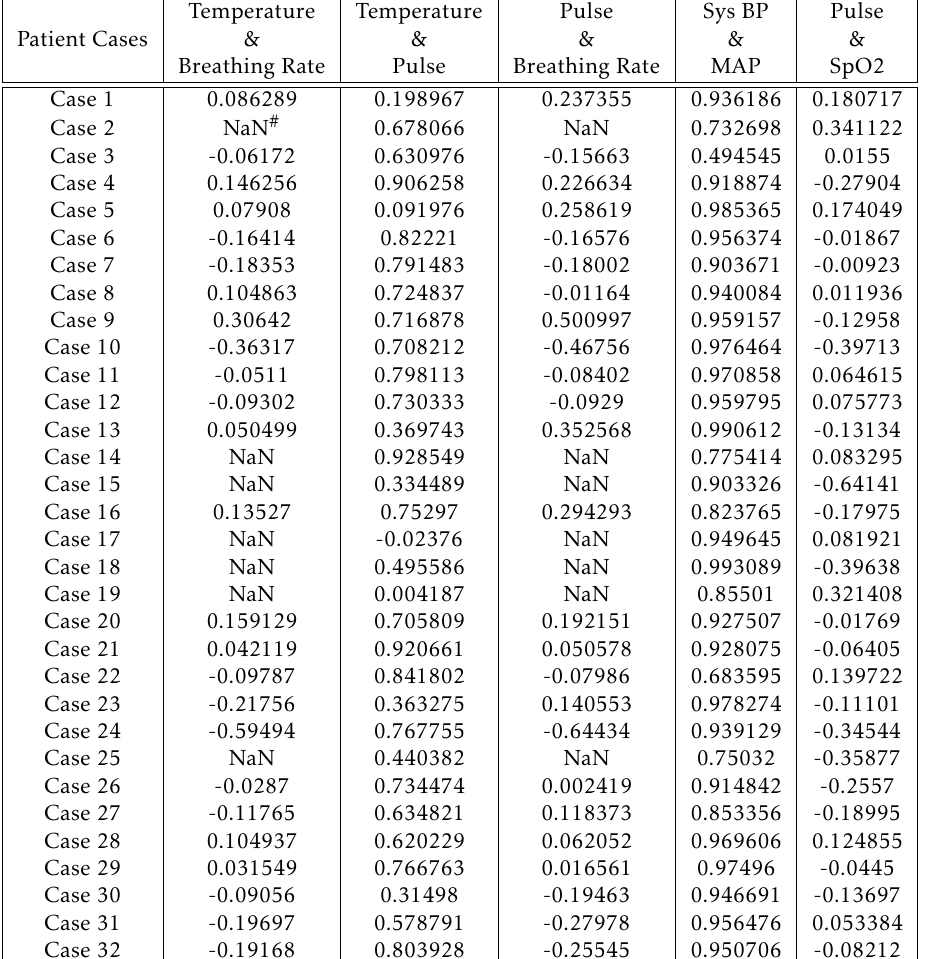
Table 2. Correlation Results of Associated Vital Signs for Sepsis, Sleep Apnea, and